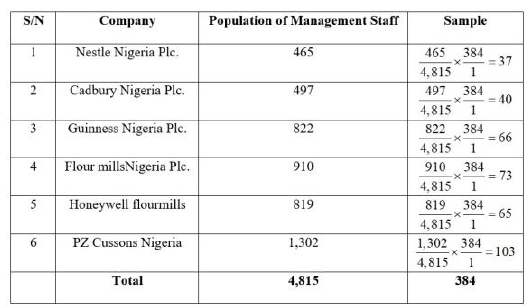
Table 1: Total Number of Managerial Staff Selected from each